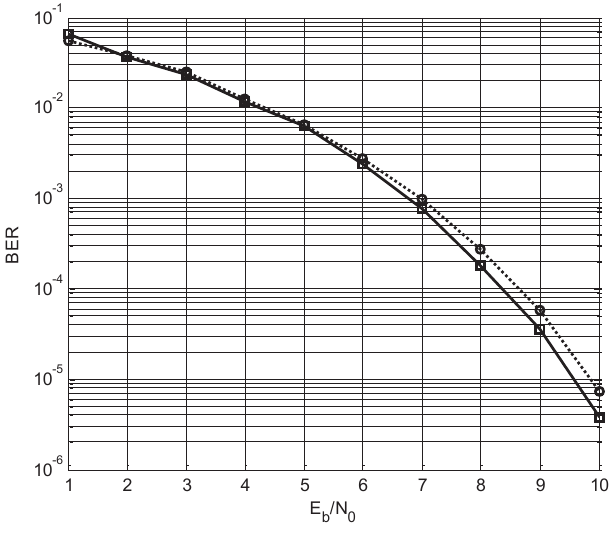
Figure 10. Bit error rate (BER) curves of the simulation